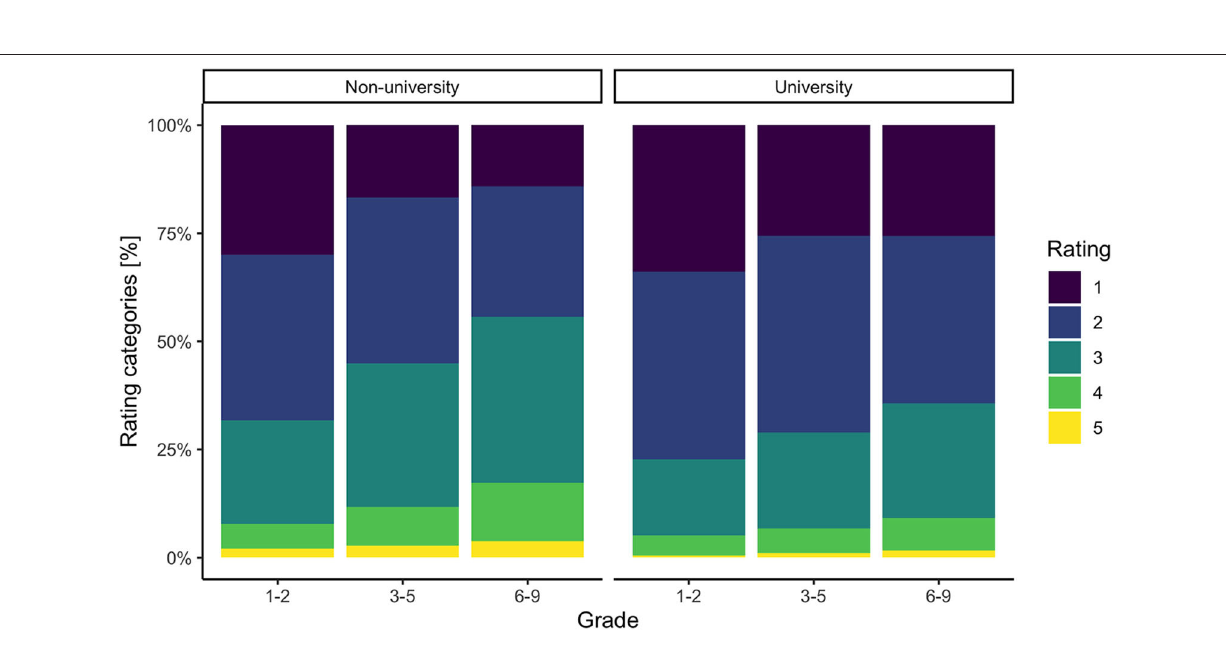
FIGURE 4 | Parental perception of how well the family is handling the home education situation (Q14 from the survey). The scale was as follows: 1—very well; 5—very poorly. Breakdown based on the child’s grade and the parents’ highest level education